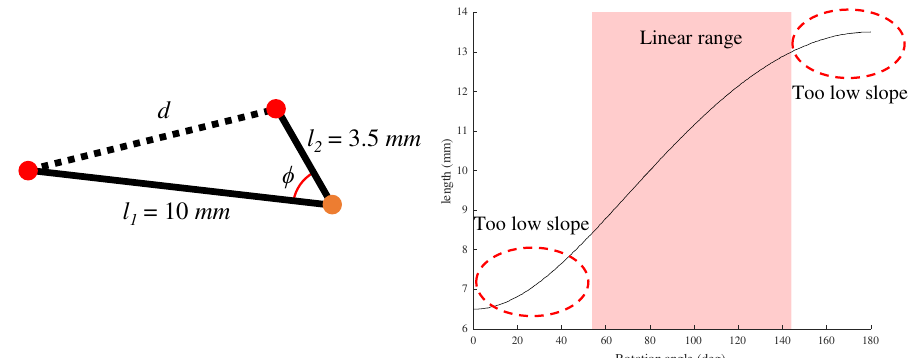
Figure 4. Distance ( d ) change according to the angle ( φ ) in a triangle.